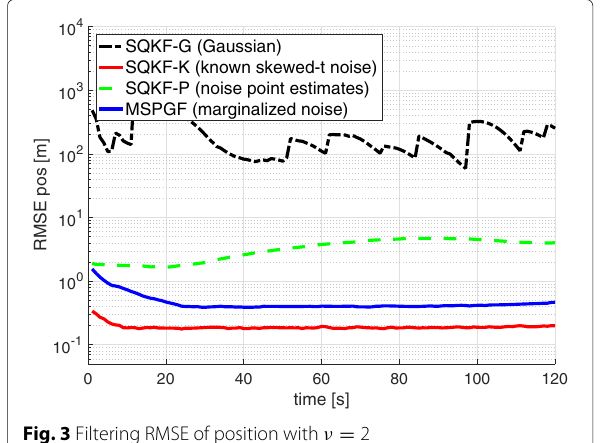
Fig. 3 Filtering RMSE of position with ν = 2